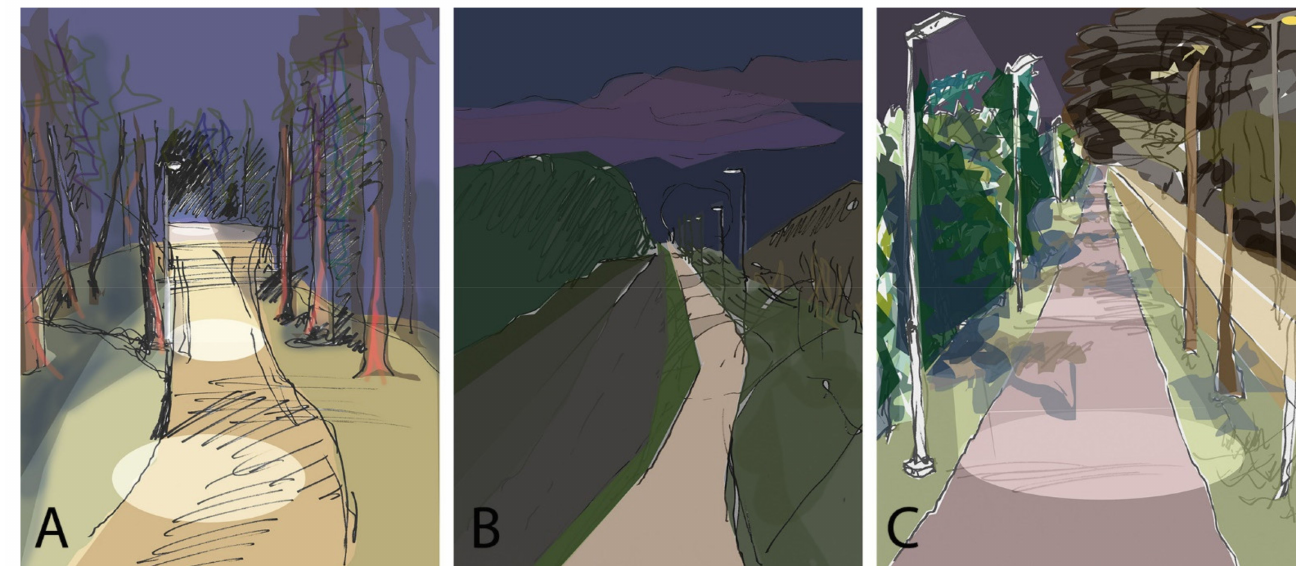
Figure 3. Analyzed sketches, from left to right: ( A ) Råslätt; ( B ) Lockebo; ( C )